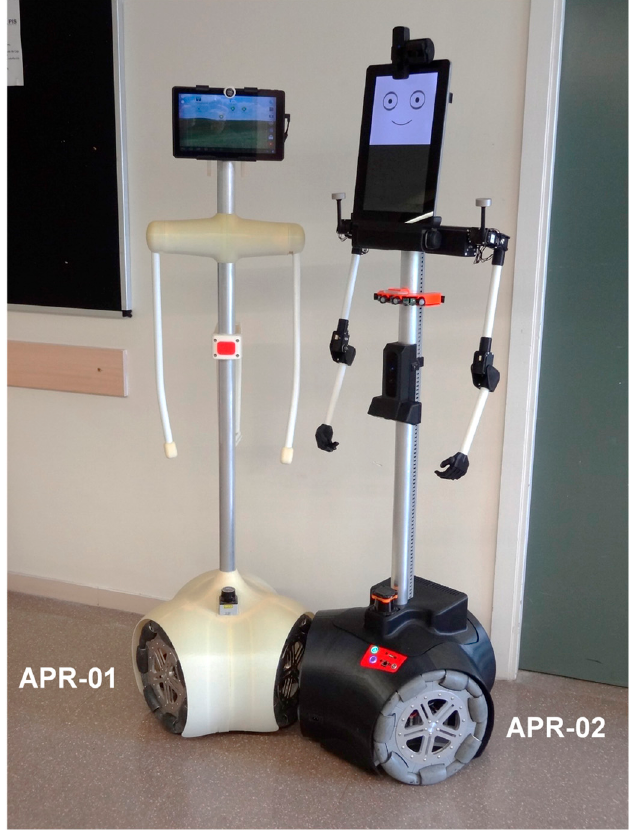
Figure 1. Mobile robots developed in the APR project: initial APR-01 prototype ( left ) and new APR-02 prototype ( right ).